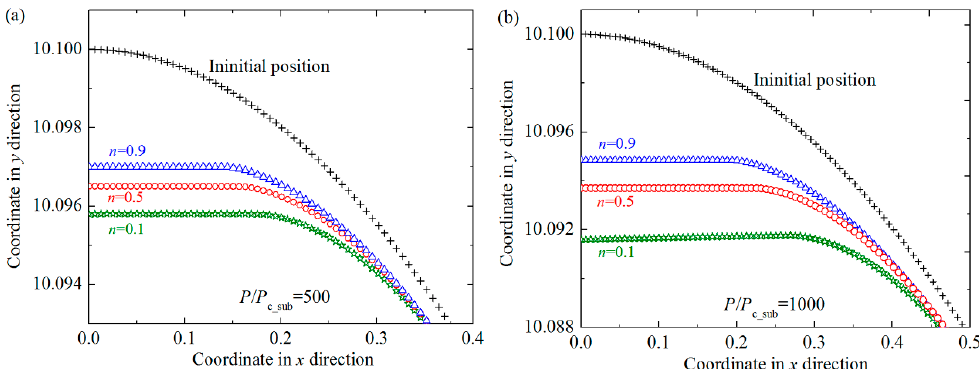
Figure 5. The profiles of the outer surface before and after the normal loading process for some typical cases where dimensionless coating thickness t/R = 0.01, Young’s modulus ratios E co /E su = 4 at different hardening exponents of the substrate n = 0.1, 0.5, 0.9 under selected dimensionless contact loads P/P c_sub = 500, 1000. ( a ) P/P c_sub = 500; ( b ) P/P c_sub =